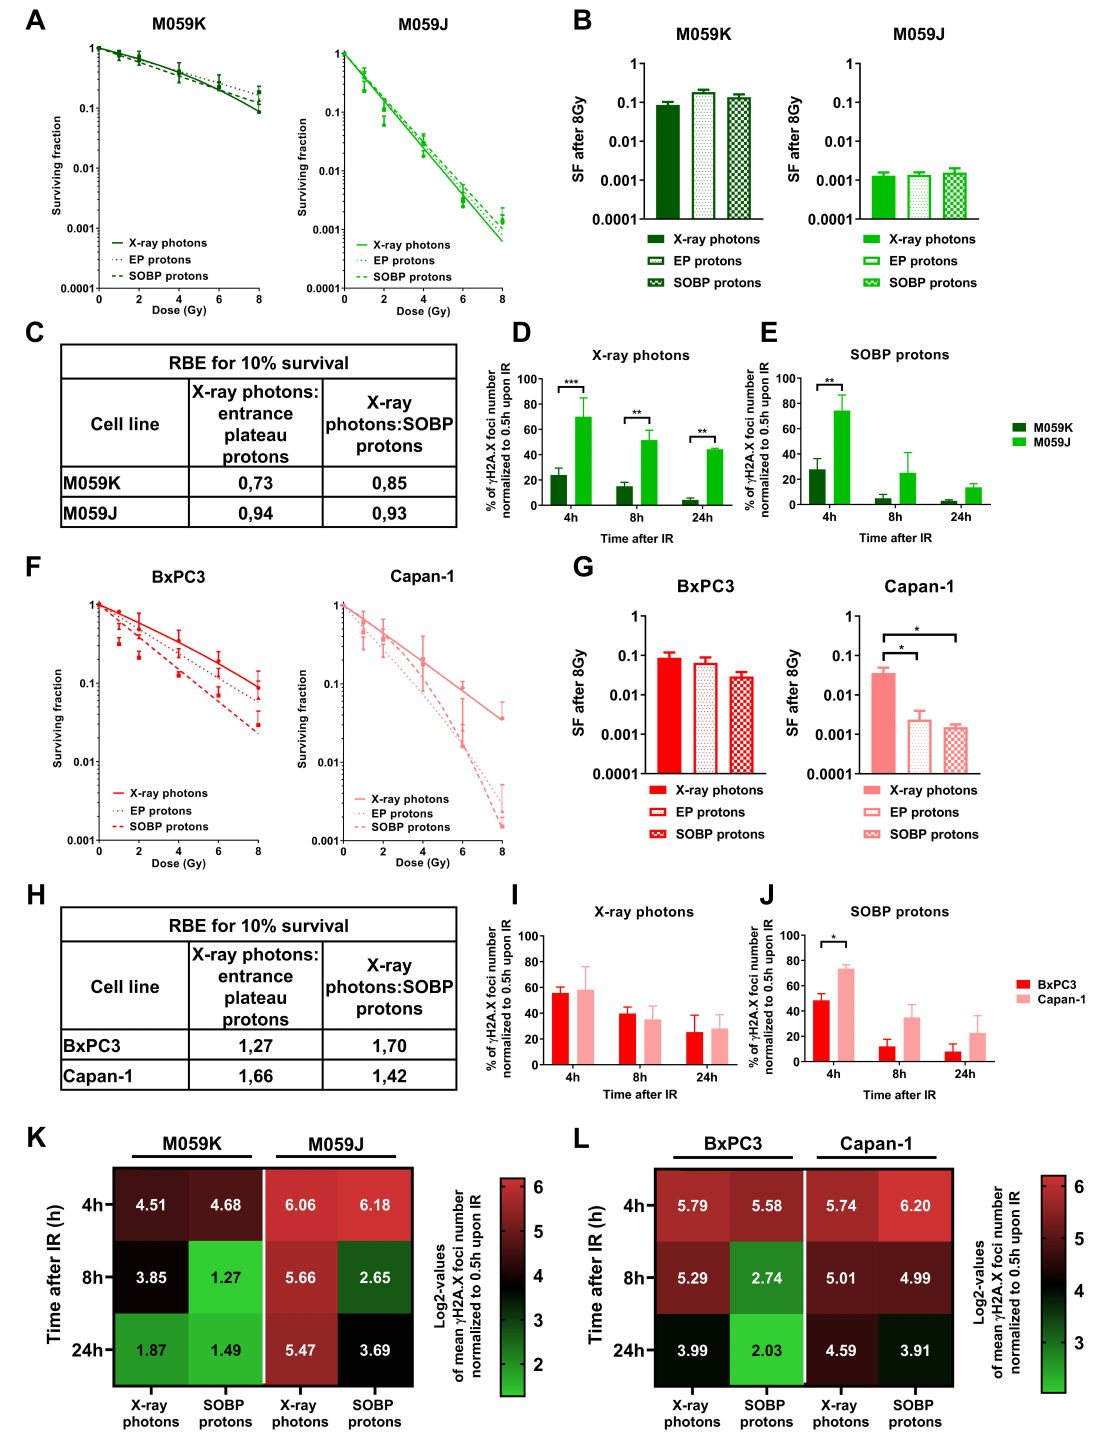
Figure 4. E ff ects of X-ray photons, EP and SOBP protons on clonogenic cell survival and kinetics in formation and removal of γ H2A.X foci in cancer cells. ( A , B ) Clonogenic survival assay of DNA-PKcs-deficient M059J and DNA-PKcs-proficient M059K glioblastoma cells irradiated with X-ray photons, EP and SOBP protons (1–8 Gy). ( C ) RBE values calculated for 10% of clonogenic cell survival of the indicated cell lines. ( D , E ) γ H2A.X foci removal over time (4–24 h) normalized to initial foci number at 30 min in M059J and M059K cells upon irradiation with 3 Gy of X-ray photons ( D )